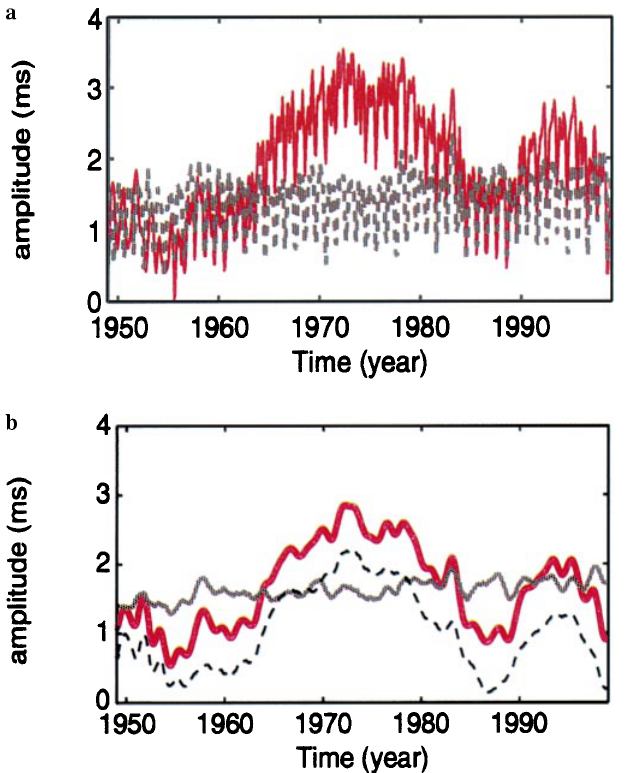
Fig. 1. a Unfiltered time series of LOD ( solid red ) and AAM (i.e. NCEP 10 ) ( dashed grey ), b seasonally filtered time series of LOD ( solid W red ), AAM (i.e. NCEP 10 ) ( solid grey ) and the di(cid:128)erence LOD-AAM W ( dashed ). Units are in